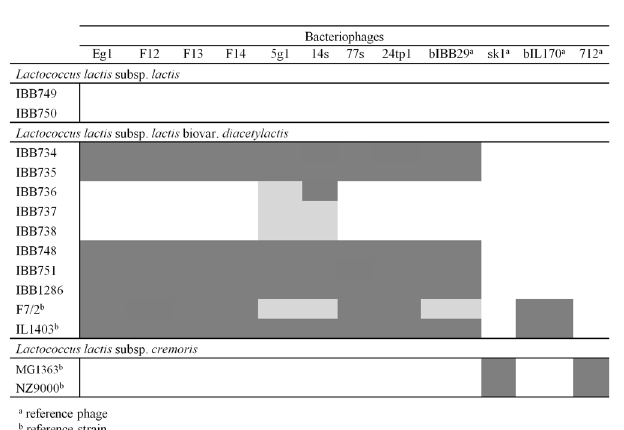
Figure 2. Host range of the studied phages tested on industrial L . lactis strains used at the time of whey sample collection. Grey-shaded boxes indicate clear plaques; light grey boxes indicate turbid plaques formed on the specified strains; white boxes signify lack of lysis. Phages bIBB29, sk1, bIL170 and 712 were used as references.